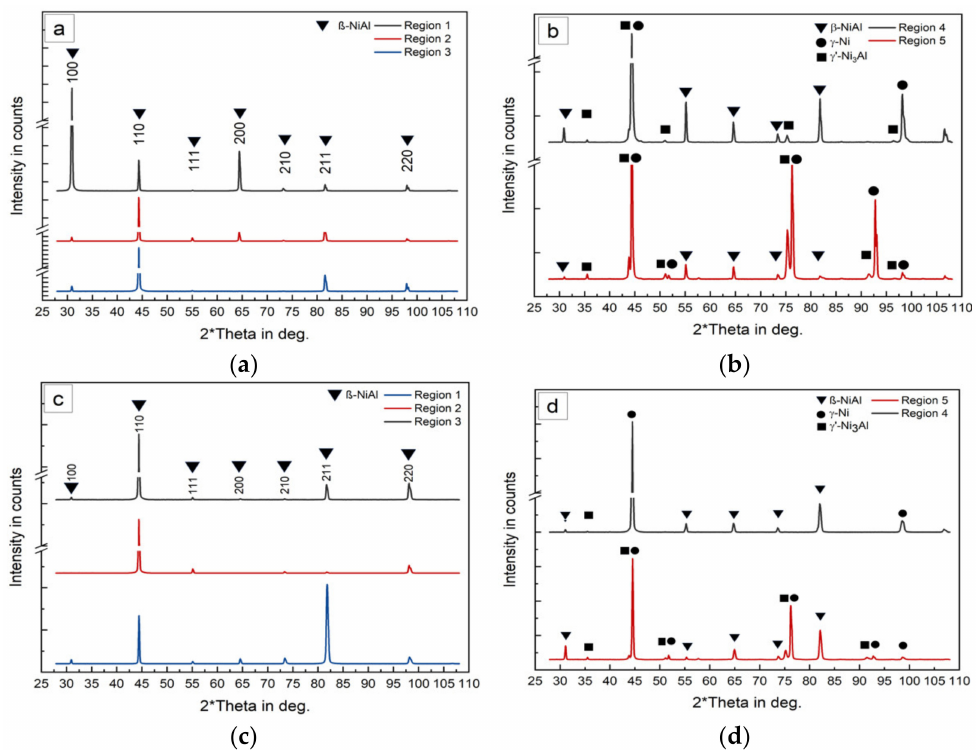
Figure 22. XRD patterns in different regions of a cuboid specimen manufactured using pre-alloyed powder ( a , b ) and in situ alloying ( c , d ), reference in Figure 14.